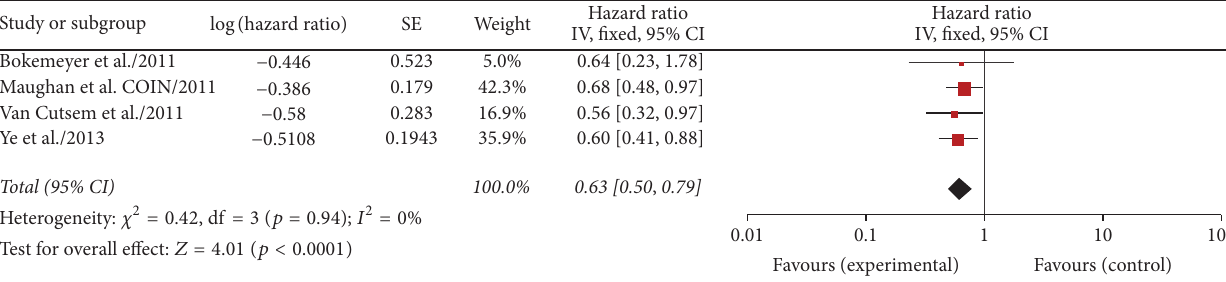
Hazard ratio IV, fixed, 95%